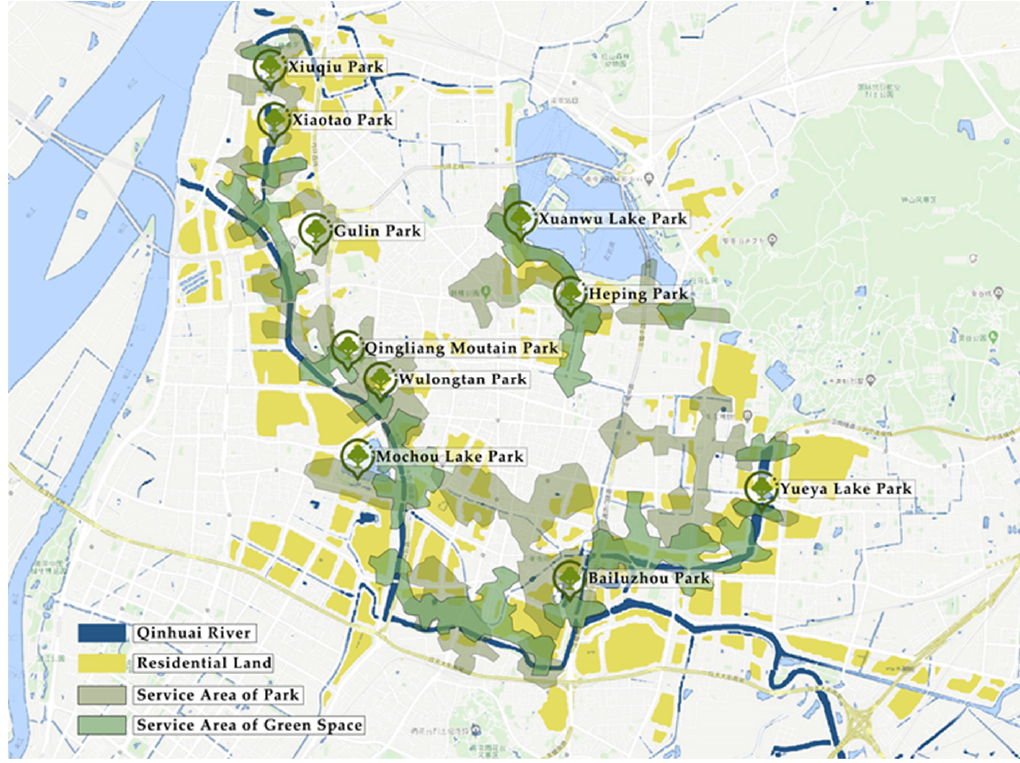
Figure 2. Geographic distribution of parks surveyed .